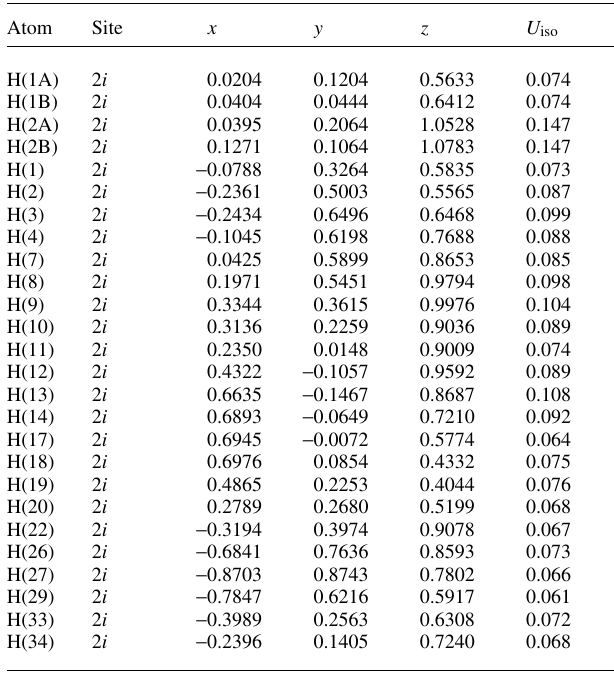
Table 2. Atomic coordinates and displacement parameters (in Å 2 ) .